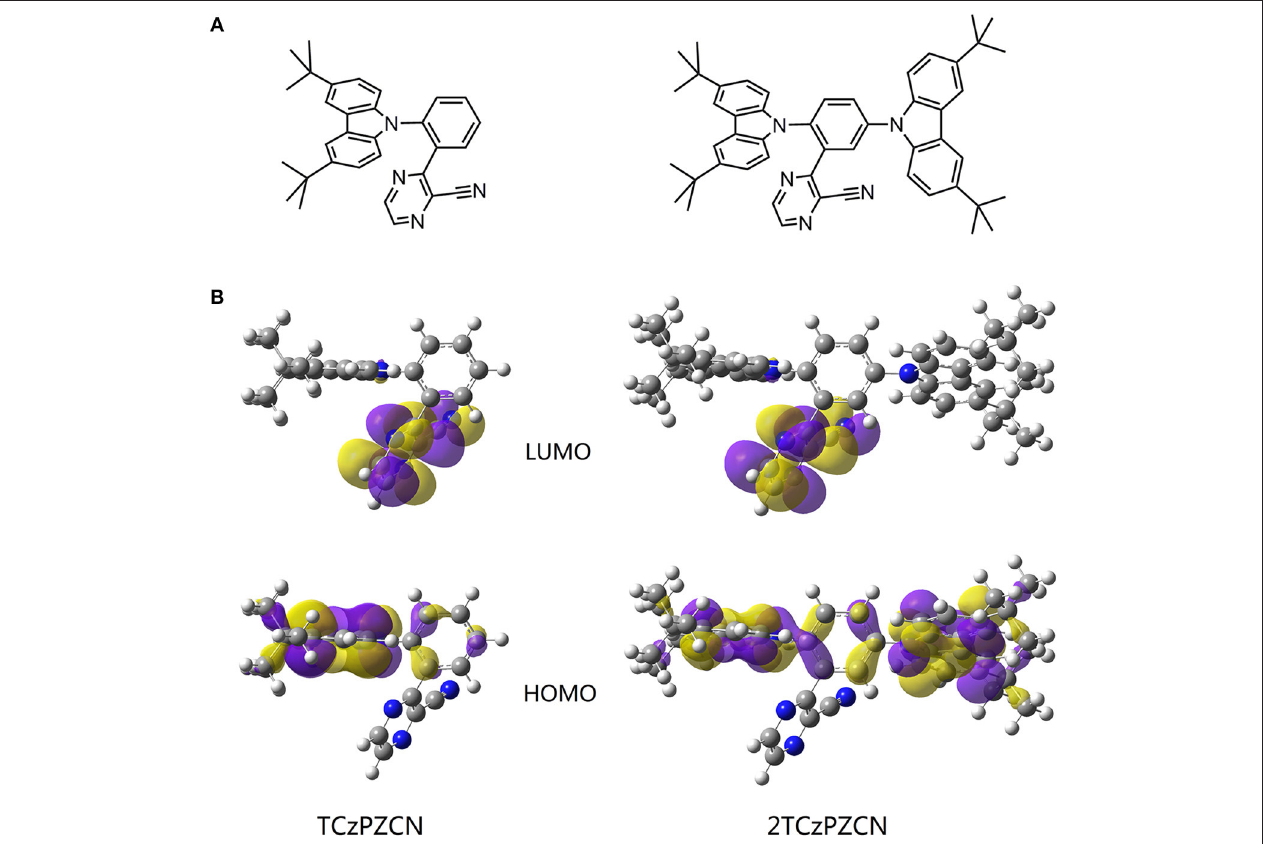
FIGURE 2 | (A) Structures of the investigated molecules. (B) The highest occupied and lowest unoccupied molecular orbitals (HOMO and LUMO) of the investigated molecules in their S0 state in vacuum. The geometries are optimized via density functional theory (DFT) at the B3LYP/6-311G (d,p)